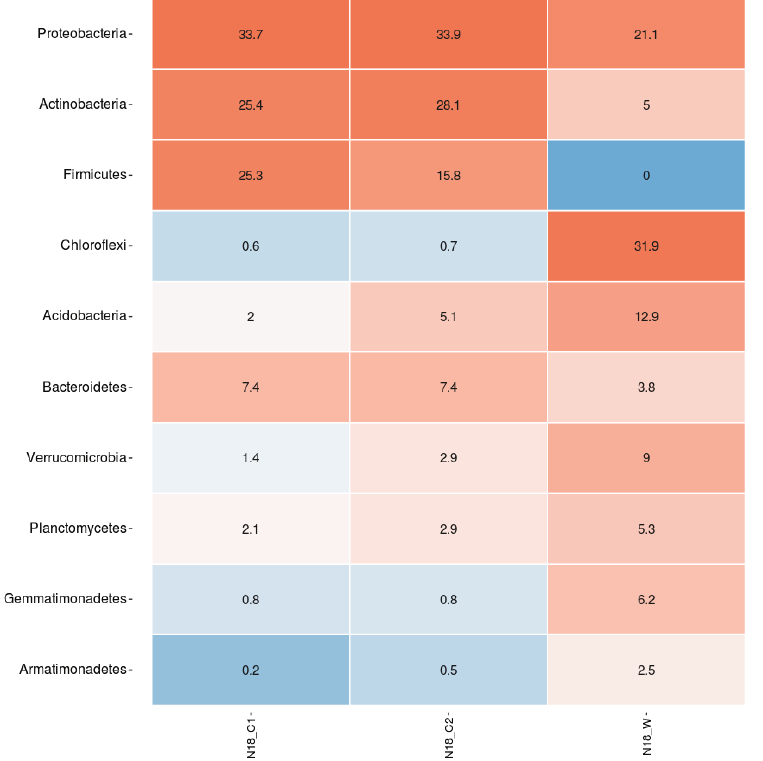
Figure 7: Top 10 phyla in 3 horizons of N18 soil sample. Numbers show percentage content of each phylum in a